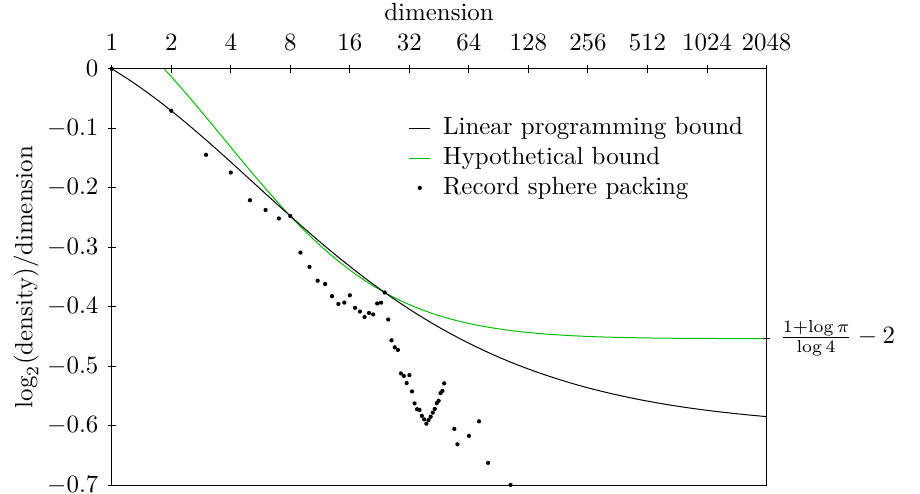
Figure 5 . The linear programming bound and the hypothetical bound based on the 1d generalized free fermion spectrum ∆ n ( c ) = n + ( c − 4) / 8 .